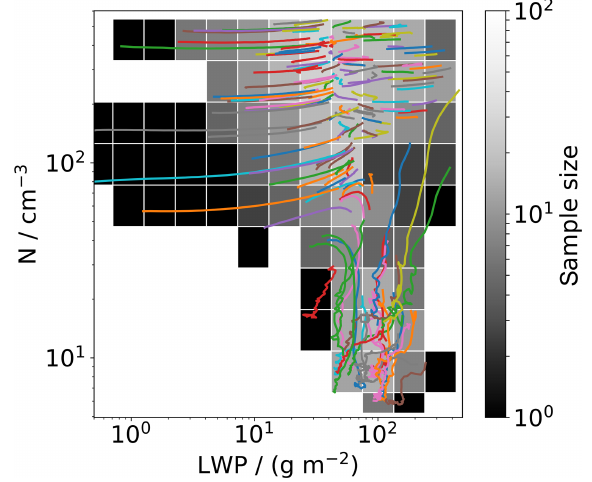
Figure 7. Illustration of sampling by trajectories. The sample size (gray scale) is determined by counting the number of trajectories (colored lines) per grid box. Note that the trajectories shown are the same as in Fig. 1.